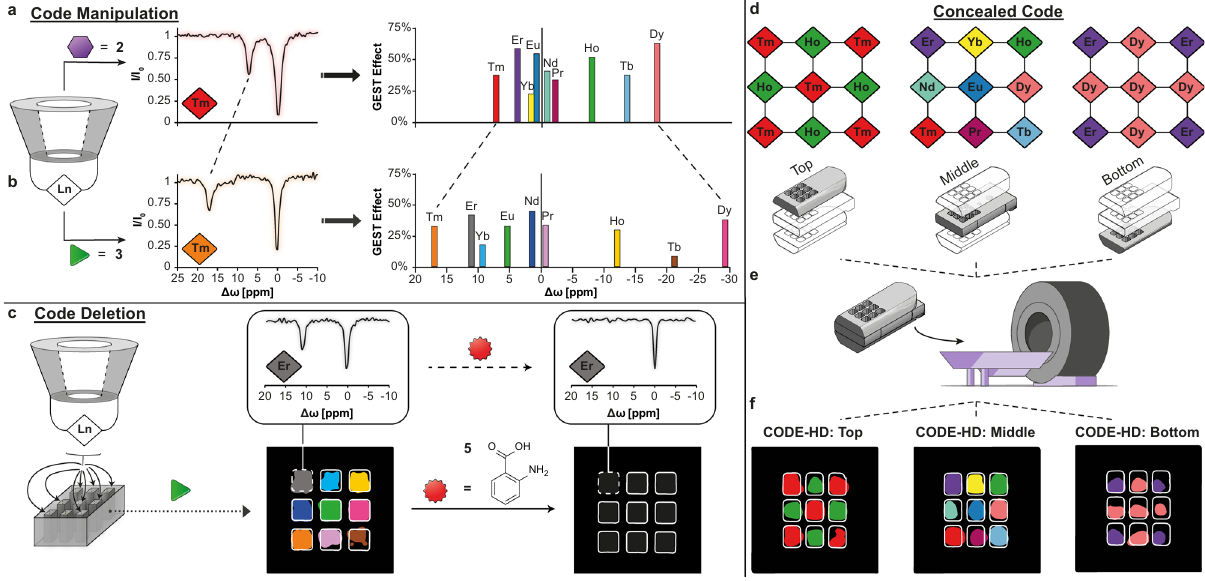
Fig. 5 Color Display by Exploiting Host – guest Dynamics (CODE-HD) code manipulation. The obtained z-spectra of a solution of thulium-cyclodextrin ( Tm-CD , red and orange diamonds) in the presence of either 2 (a, purple hexagon) or 3 (b, green triangle), and plots showing the obtained chemical shift offset ( Δ ω ) values from paramagnetic guest exchange saturation transfer (paraGEST) experiments with different lanthanide-cyclodextrins ( Ln-CDs ) as the hosts and either 2 ( a ) or 3 ( b ) as the guest, and the assigned colors for each host – guest pair (assigned at Supplementary Tables 3 and 8); c CODE-HD color map obtained from different pairs of Ln-CD and 3 , which is deleted upon anthranilic acid ( 5 , red star) addition to each one of the wells in the plate. The z-spectra obtained from the well containing erbium-cyclodextrin ( Er-CD , gray diamond) before and after the addition of 5 is shown in the insets; CODE-HD of a sealed three-dimensional (3D) multilayer object. d Scanned object scheme, composing of three 3 × 3 multiwell plates, and different Ln-CD:2 pairs loading patterns (diamonds), e complete object and MRI schemes, re fl ecting the inability to discover the content of each layer and f generated CODE- HD maps (rectangles) of each